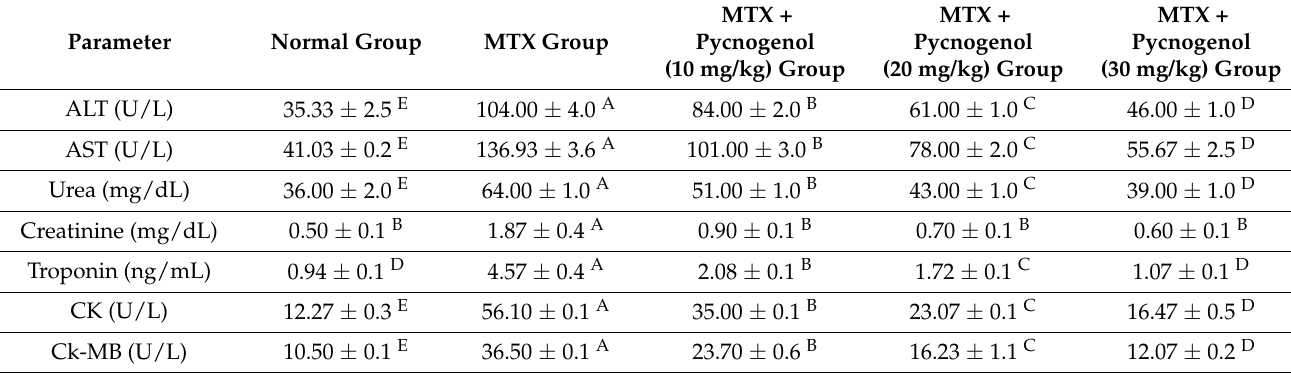
Table 1. Effect of MTX and pycnogenol treatment on serum